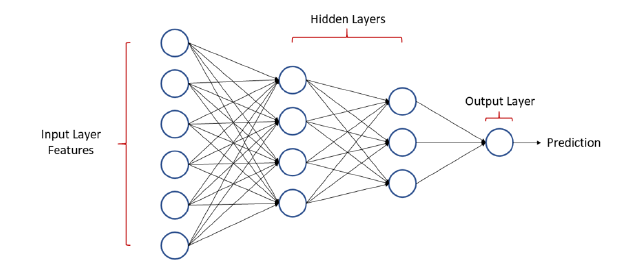
Figure 21. Schematic of a feedforward Artificial Neural